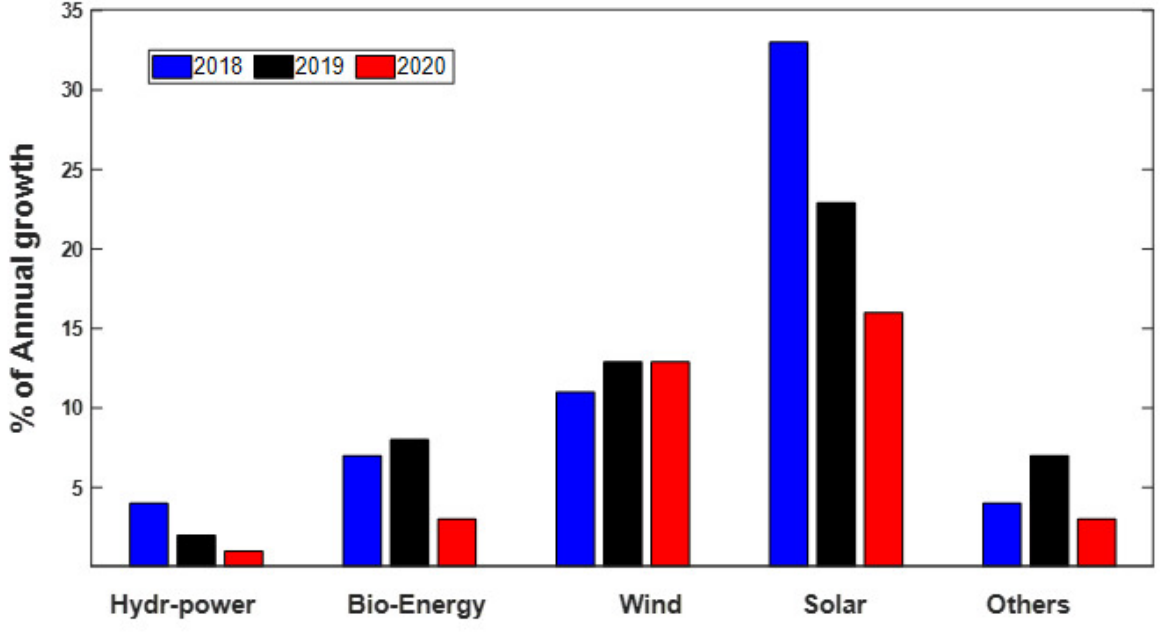
Figure 1. Annual growth for renewable energy electricity generation by source